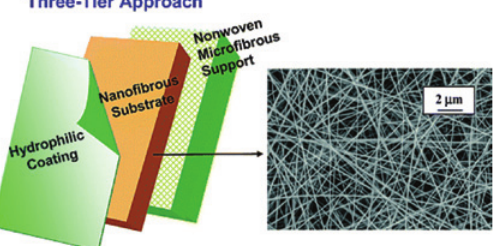
Figure 14: Three-tier approach to fabricate high flux membranes. For details, see Ref. [55]; reprinted with permission from American Chemical